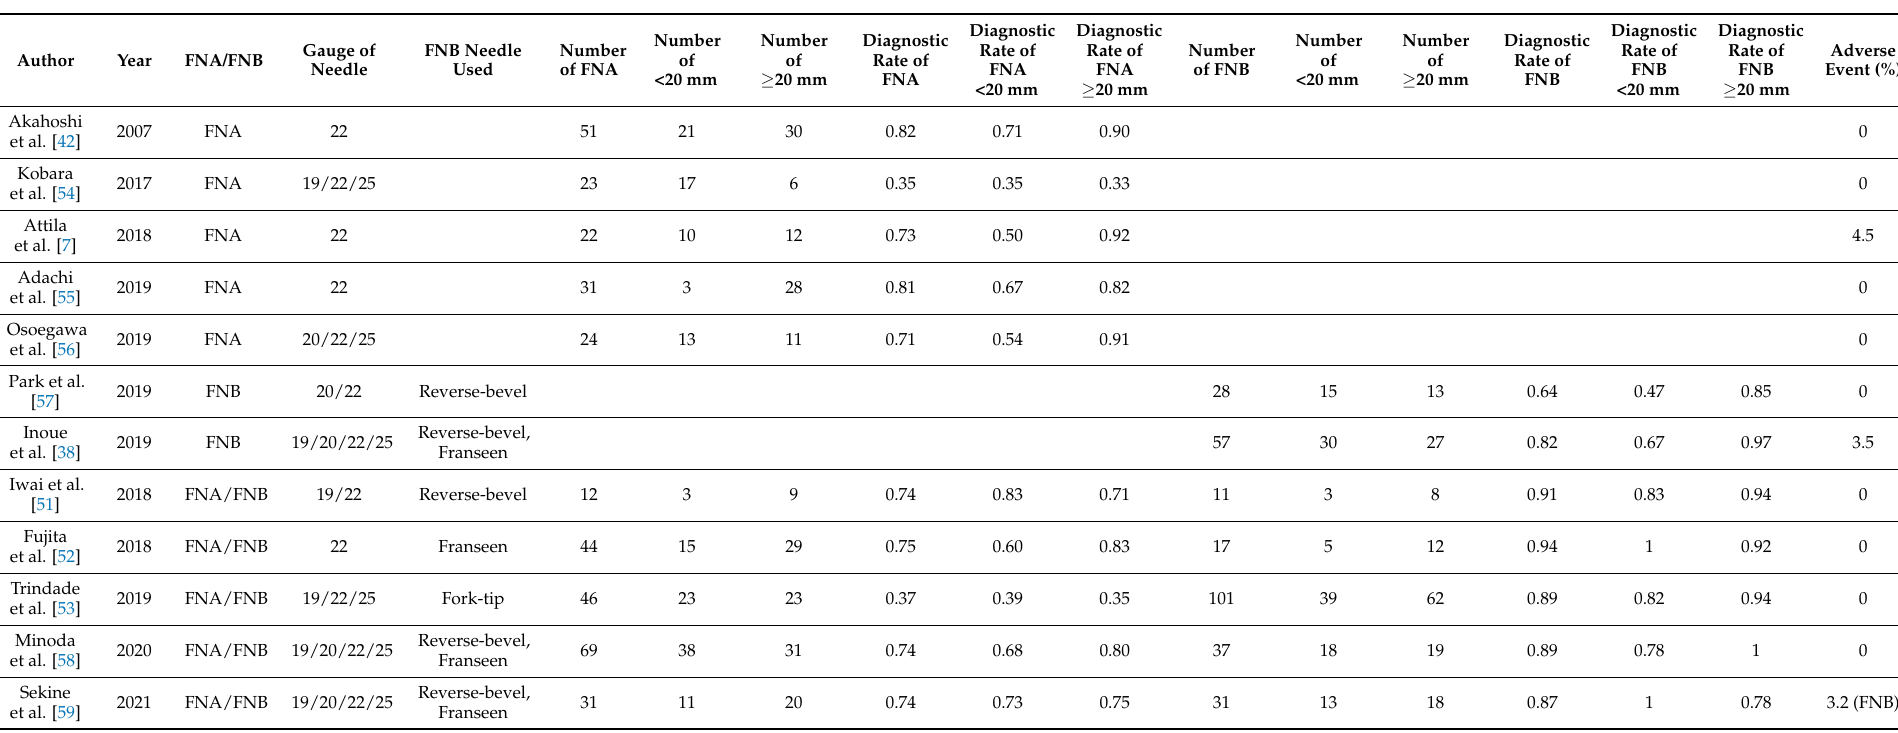
Table 1. Details of studies on EUS-FNA and